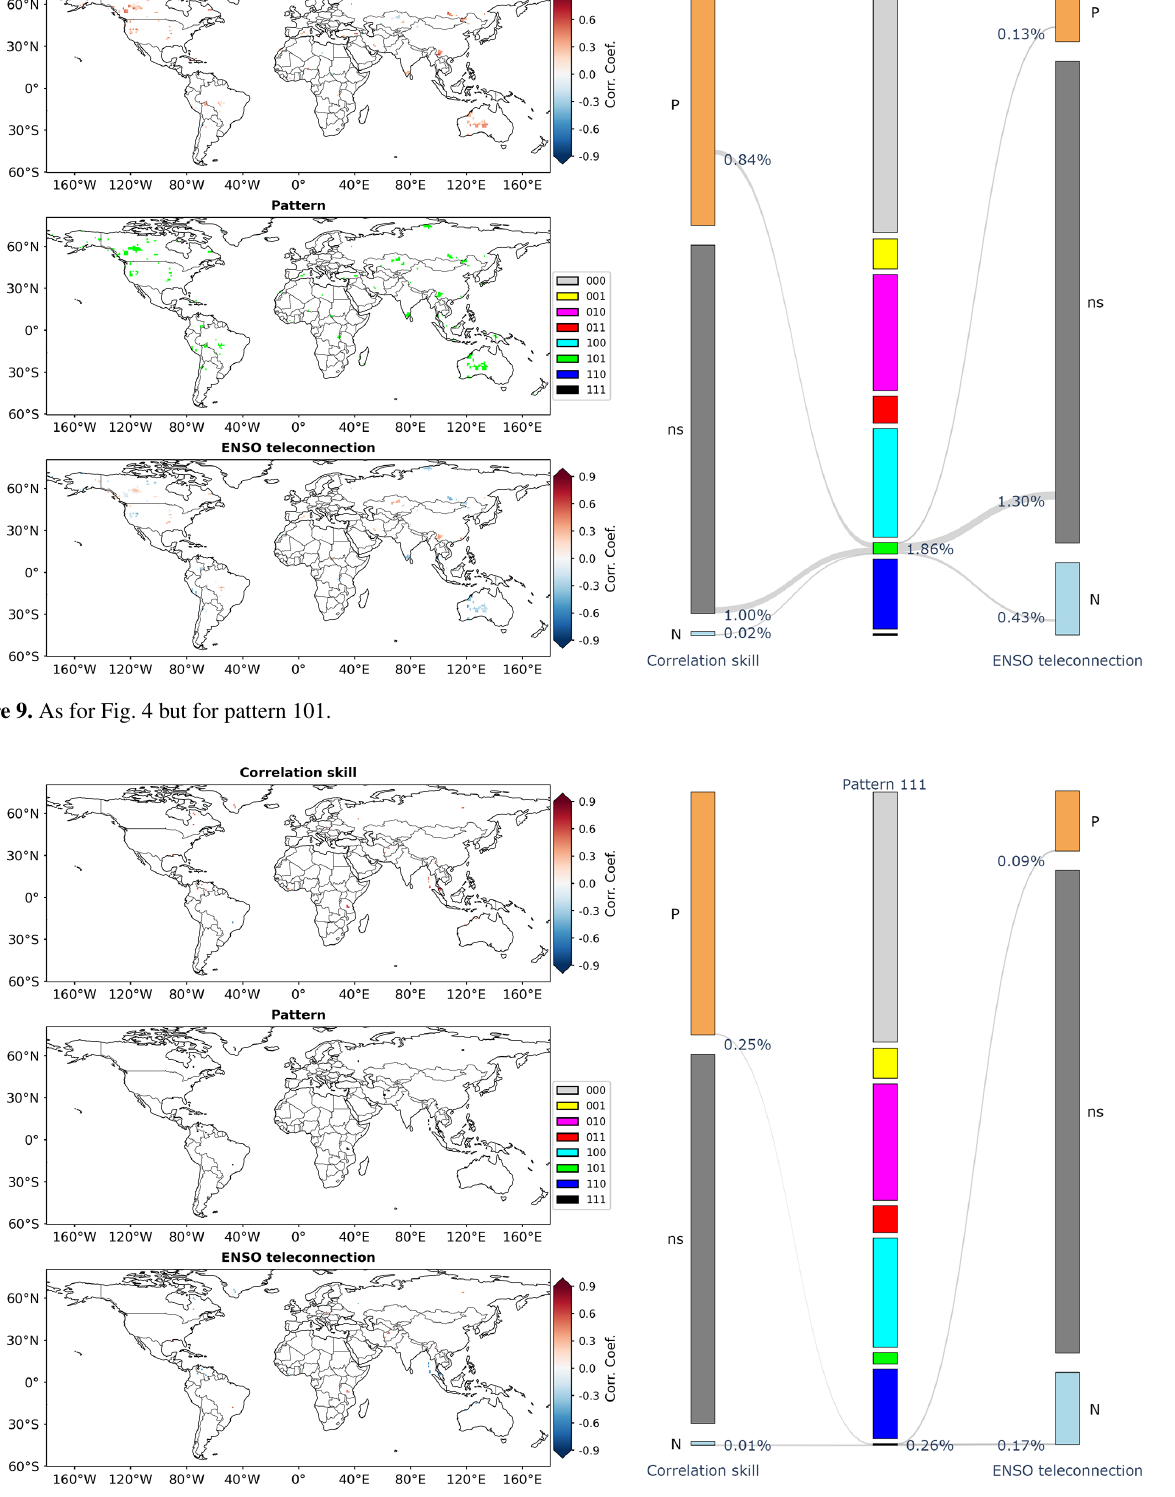
Hydrol. Earth Syst. Sci., 26, 4233–4249, 2022